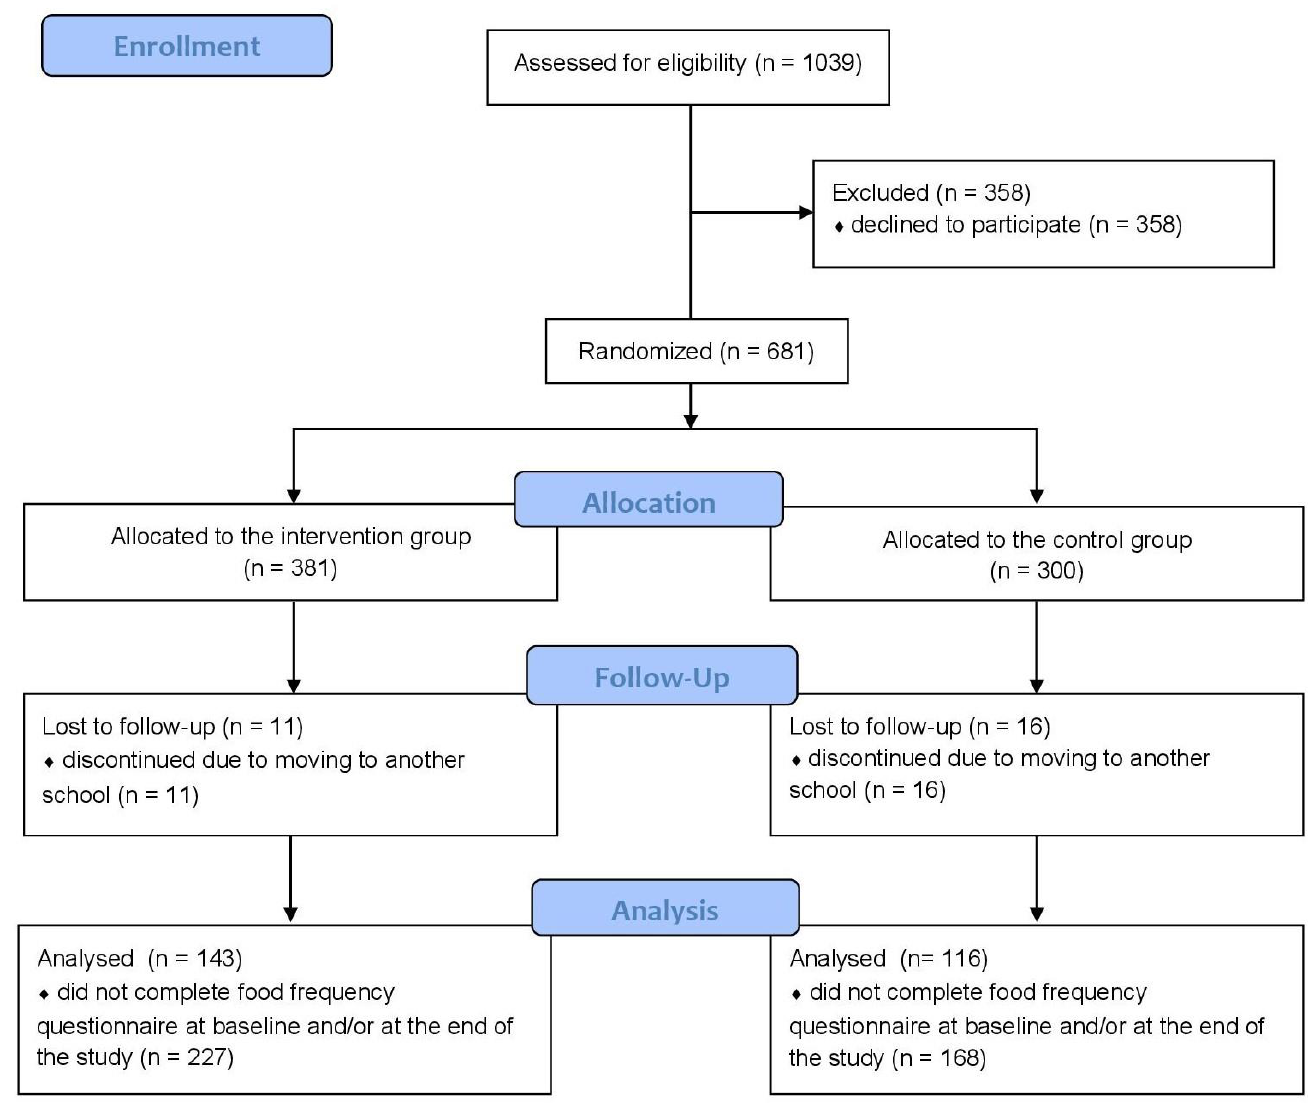
Figure 2. The CONSORT flow diagram for the resent study.